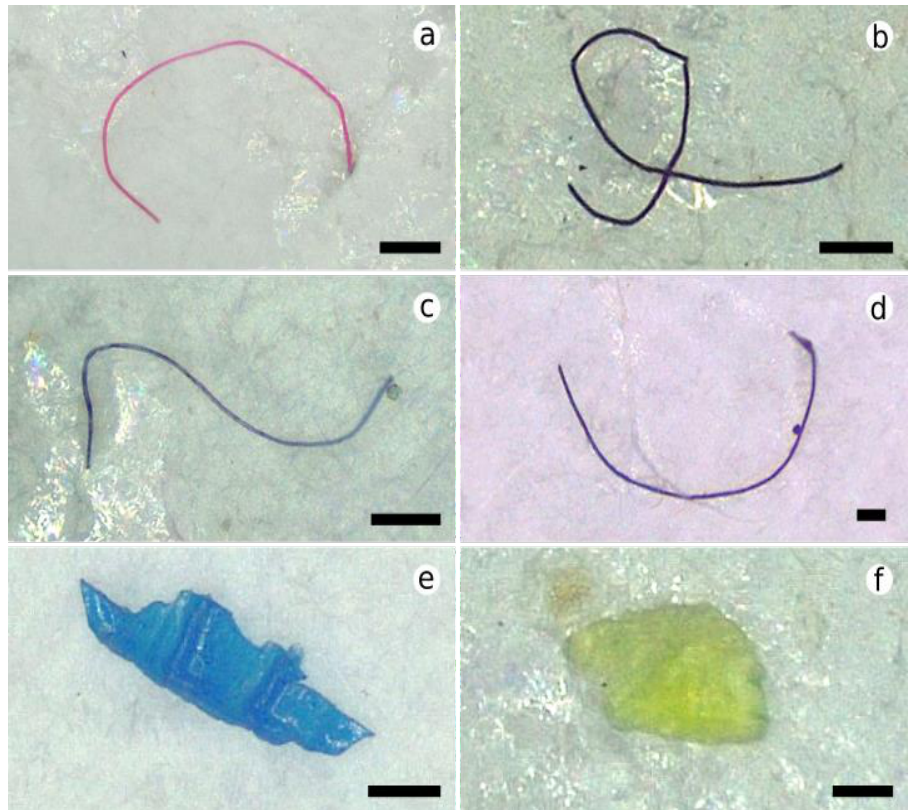
Figure 3. Examples of microplastics found in clams from the two estuaries in Da Nang: ( a – d ) fiber; and ( e , f ) fragment. All scale bars represent 100 μm.